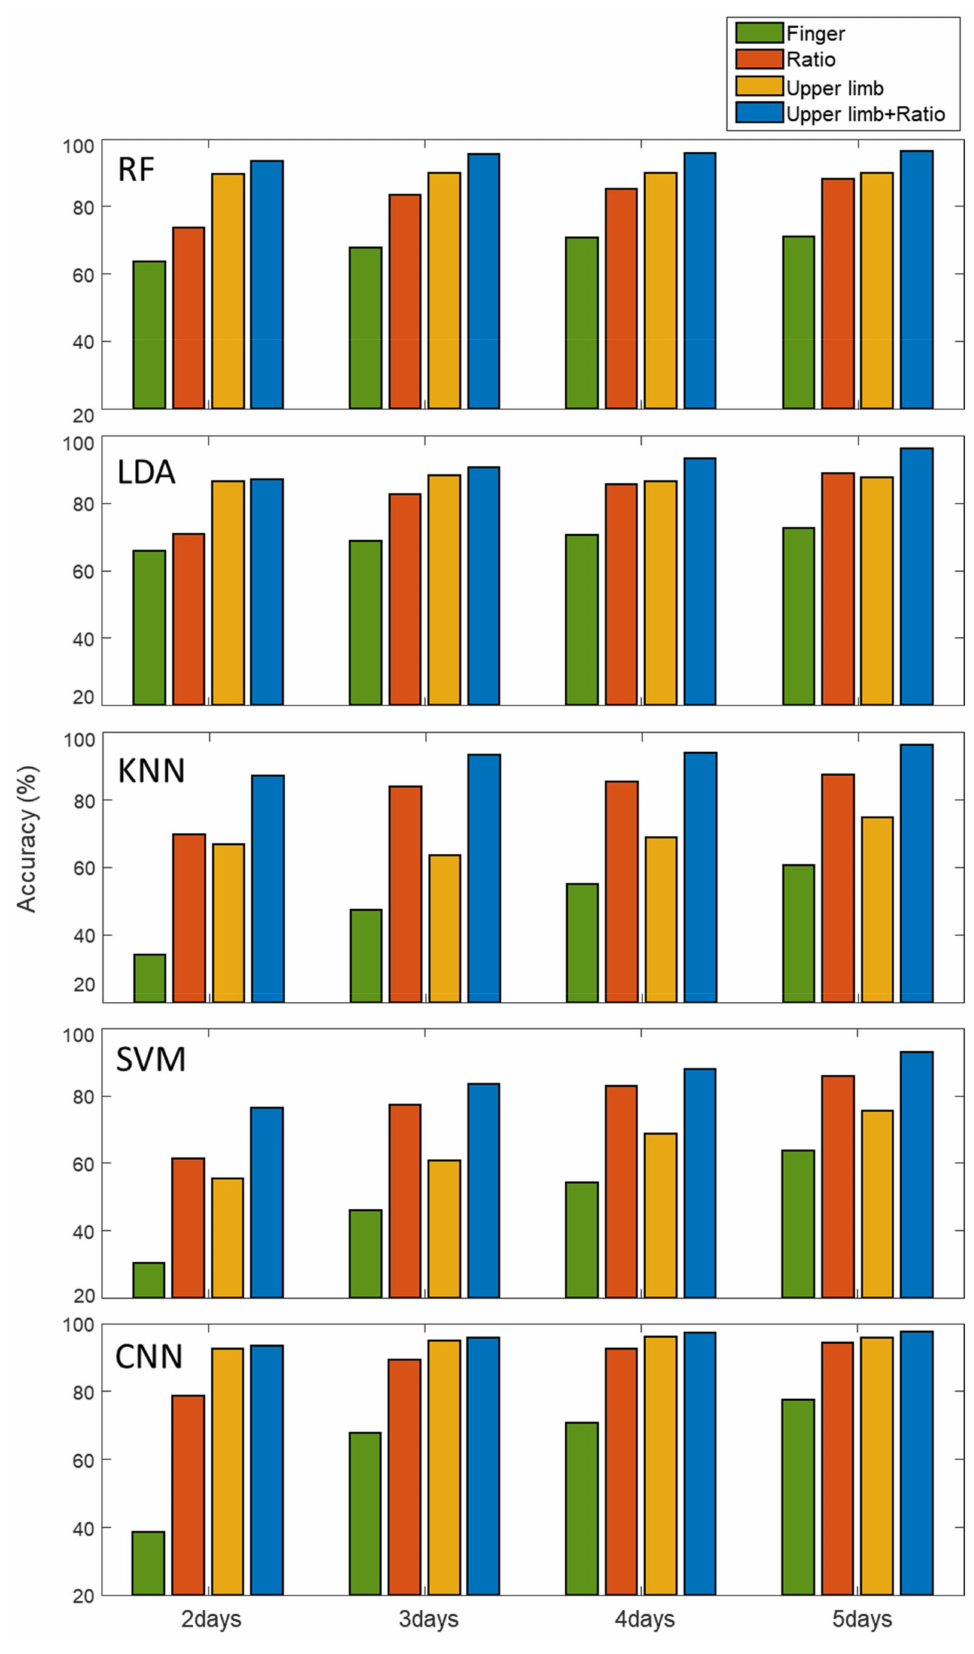
Figure 6. Comparison of identification accuracies according to the types of features used in the five different classifica- tion